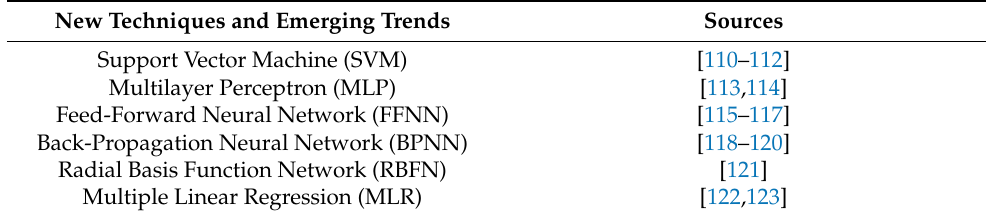
Table 1. New Techniques and Emerging Trends towards Sustainability. New Techniques and Emerging